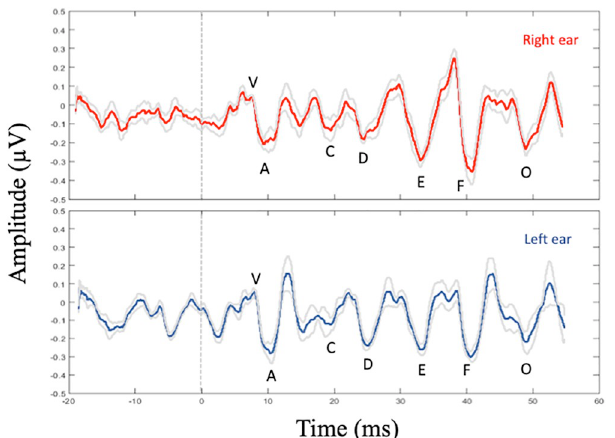
Fig 3. Grand average waveform for the speech-ABR obtained from 62 older adults to right (red line) and left (blue line) ear presentation of 40-ms speech syllable /da/. The stimulus evoked seven prominent peaks, labeled as V, A, C, D, E, F and O. The light-gray lines represent ± 1 SE of the mean for the left and the right ears for the entire group of older adults.